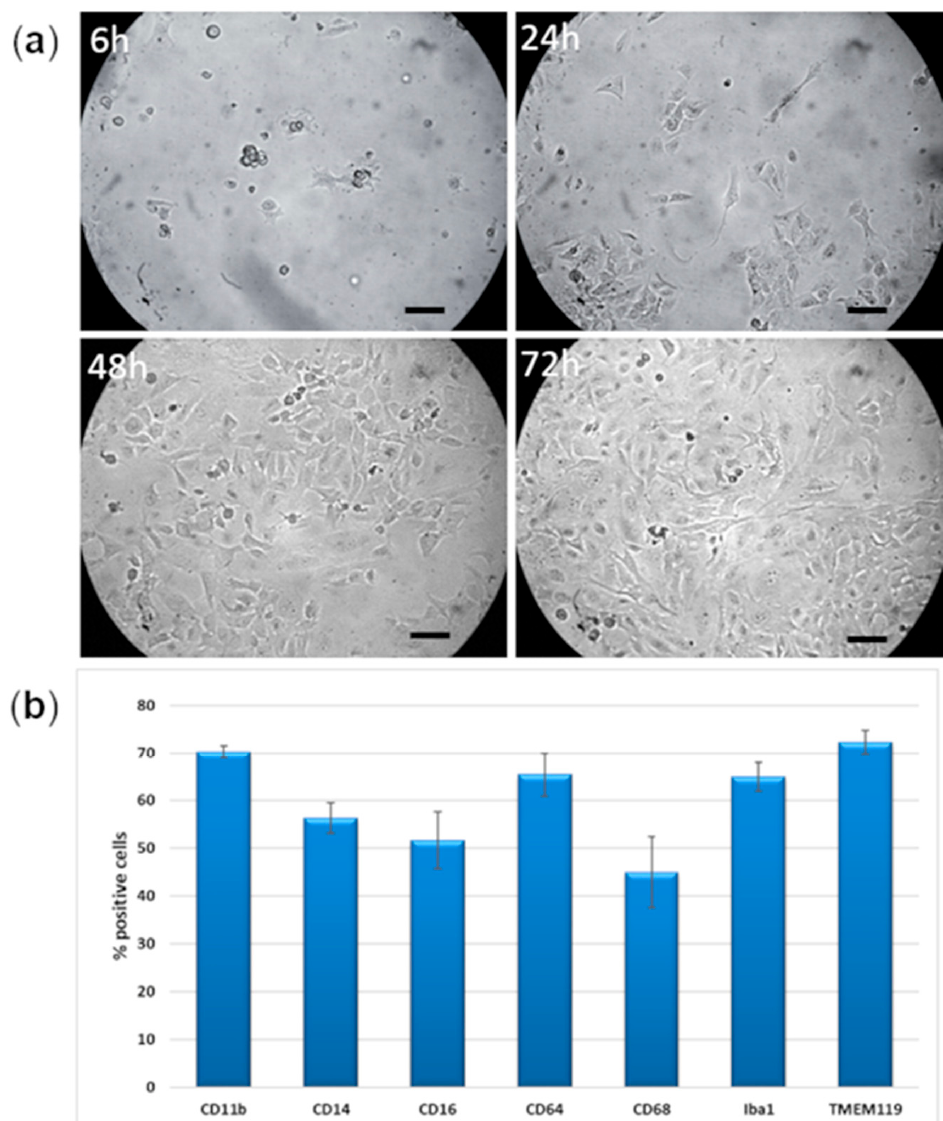
Figure 1. ( a ) Morphological aspect of immortalized human microglial cells (IM-HM) in physiological conditions, after 6, 24, 48, and 72 h from thawing. Images were taken at 20x objective magnification and scale bar indicates 50 μ m. ( b ) Expression of human microglial markers in IM-HM in physiological conditions after 48 h from thawing, as a percentage of positive cells.